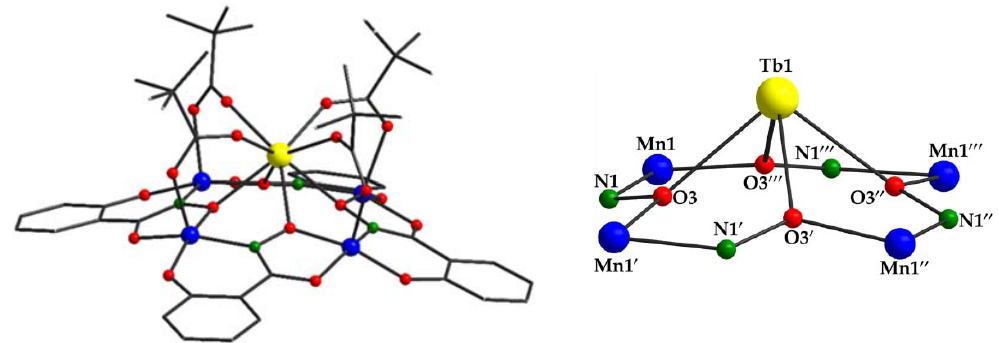
Figure 1. Schematic representation of molecular structure and labeled schematic representation of the core {Mn 4III Ln III ( µ -NO) 4 } 11+ of complex 2 . Color scheme: Tb, yellow; Mn III , blue; N, green; O, red. H atoms are omitted for clarity.